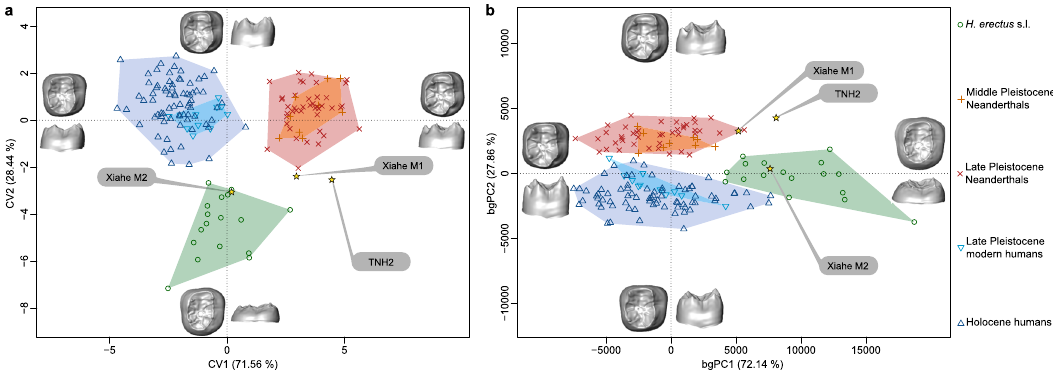
Fig. 5 Geometric morphometric analyses of the EDJ. Canonical variate analysis ( a ) and between-group principal component analysis ( b ) of the EDJ deformation-based shape comparison of TNH2-1, H. erectus s.l., the Denisovan specimen from Xiahe, Neanderthals and H. sapiens . Source data are provided as a Source Data fi